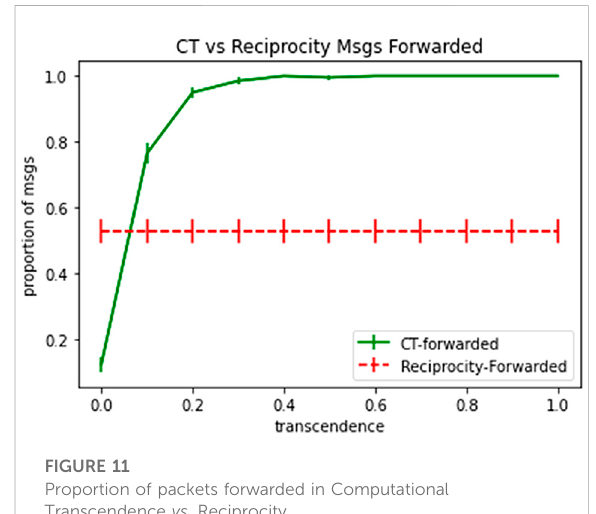
FIGURE 11 Proportion of packets forwarded in Computational Transcendence vs .